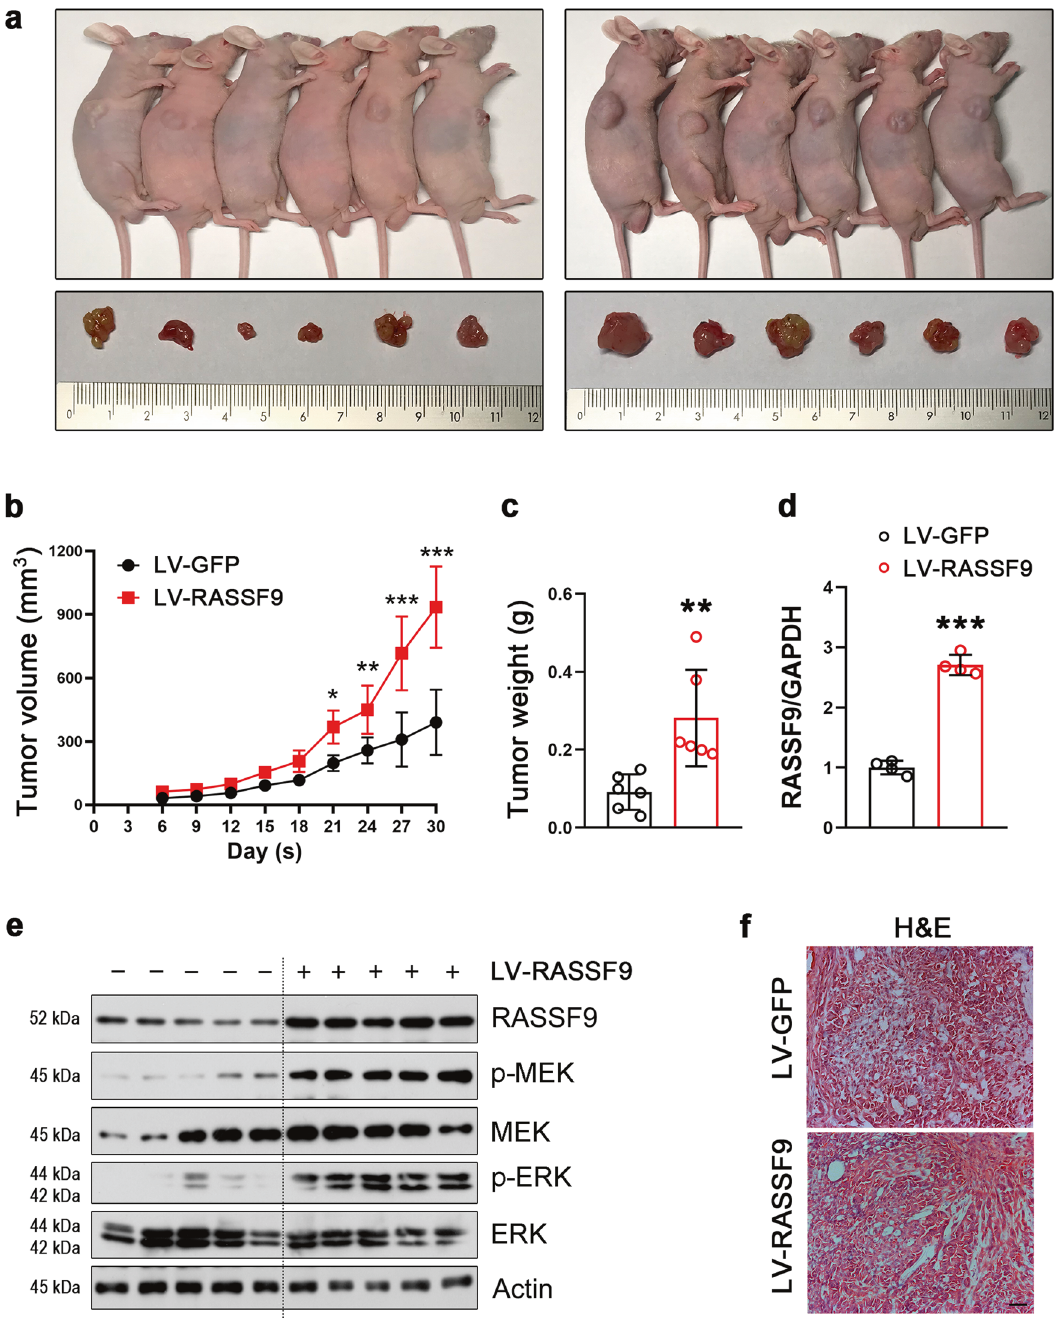
Fig. 8 RASSF9 promotes NSCLC tumorigenesis in vivo. A549 cells were transduced with lentivirus expressing Ras sf9 (LV-RASSF9) or Gfp (LV- GFP). After screening with puromycin, the cells stably expressed RASSF9 or GFP were implanted into nude mice. a The representative images of gross subcutaneous tumors in nude mice and images of xenograft tumors dissected from nude mice ( n = 6). b RASSF9 stimulates tumor volume ( n = 6). c RASSF9 increases tumor weight ( n = 6). d RASSF9 expression in the transplanted tumors was increased by LV-RASSF9 ( n = 4). Gene expression was analyzed by qRT-PCR and GAPDH was used as house-keeping gene. e The protein levels of RASSF9, p-MEK, MEK, p-ERK, ERK in the transplanted tumors ( n = 5). Protein levels were analyzed by western blot and Actin was used as loading control. f H&E staining. Scale bar = 200 μ m. Data are presented as means ± SD (error bars). * P < 0.05, ** P < 0.01, and *** P < 0.001. Student ’ s t